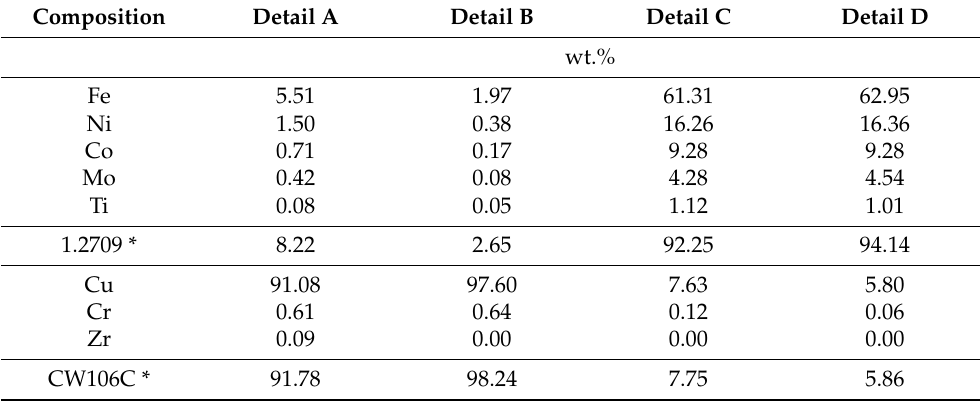
Table 2. Element and material composition of the details highlighted in Figure 5, N4.4 and N4.5, measured via SEM EDS. *